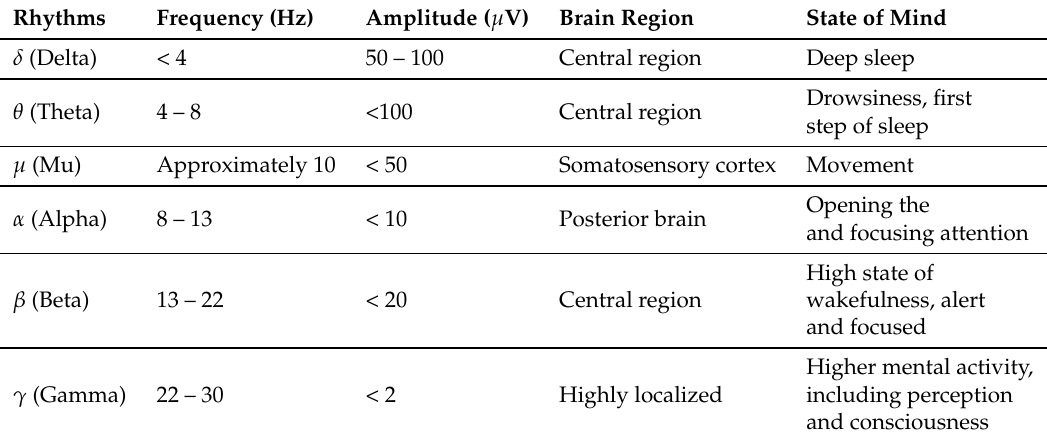
Table 1. Categorization of the EEG rhythms based on their frequency.